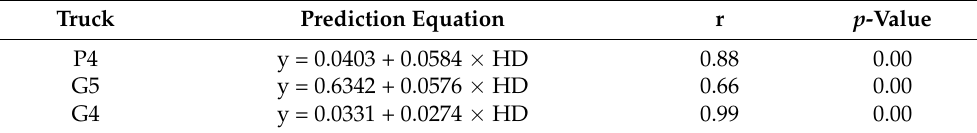
Table 6. Output of the regression and correlation analysis between the fuel consumption (y; L m − 3 ) and haulage distance (HD; km) for the Scania P450 (P4), G500 (G5), and G440 (G4) logging trucks. Truck Prediction Equation r p -Value P4 y = 0.0403 + 0.0584 × HD